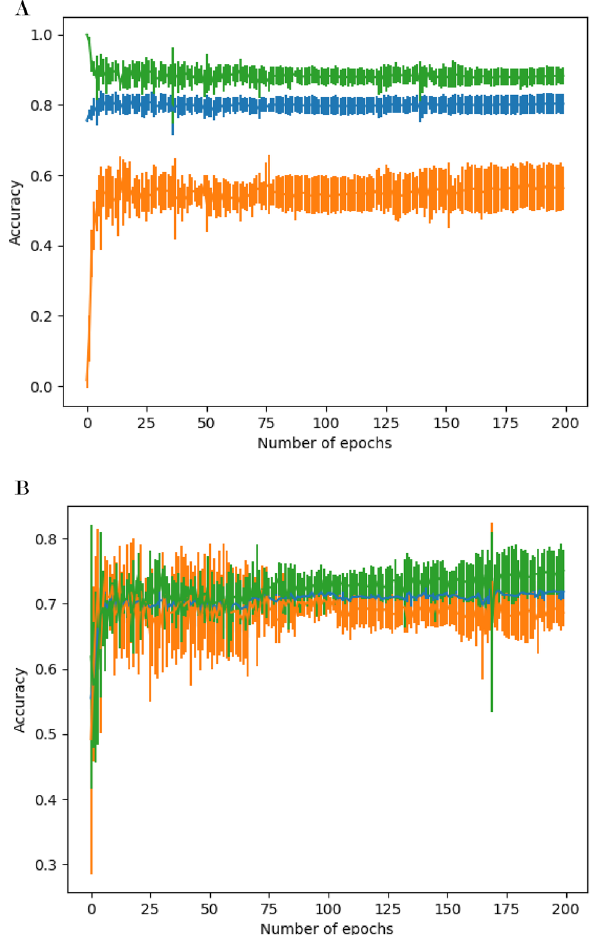
Figure 4. Average prediction accuracy on validation groups in cross-validation. Average of prediction accuracy was calculated on 5 validation groups in cross-validation. ( A ) Whole sets in 72-primer-31template sets were used for learning or validation. ( B ) The number of primer pair-template sets in 72-primer-31template was controlled to 1:1 by undersampling. Groups are Orange: PCR positive primer pair-template sets, Green: PCR negative primer pair-template sets, and Blue: all primer pair-template sets. Standard deviation within validation groups was shown as error